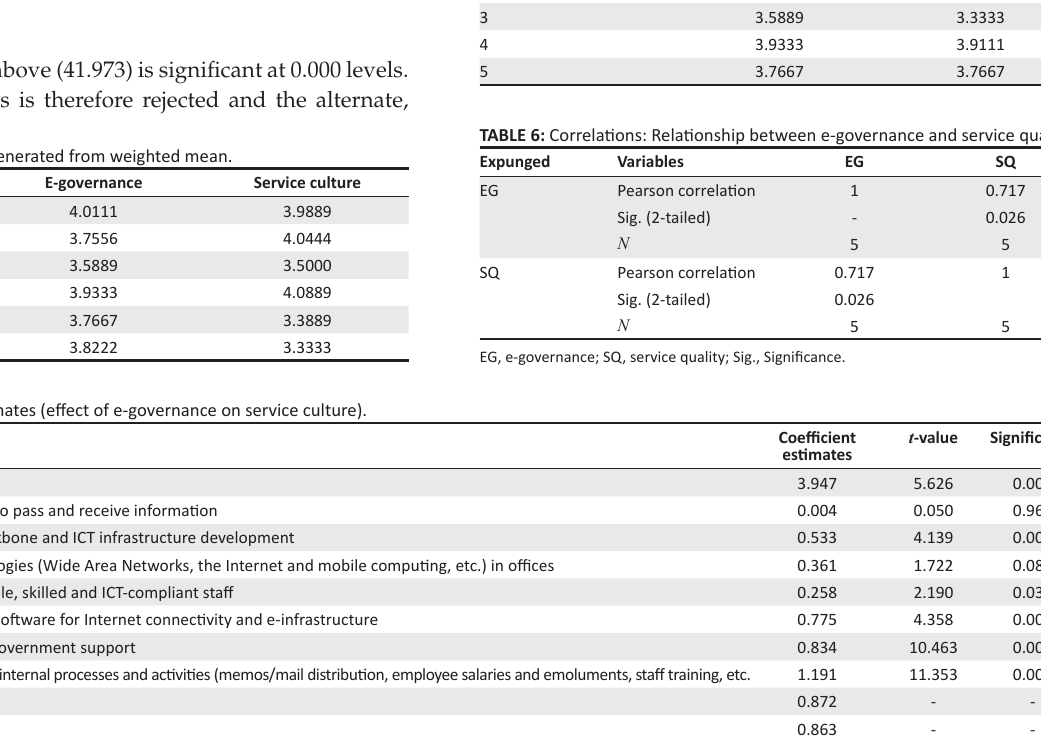
TABLE 5: Available data generated from weighted mean.